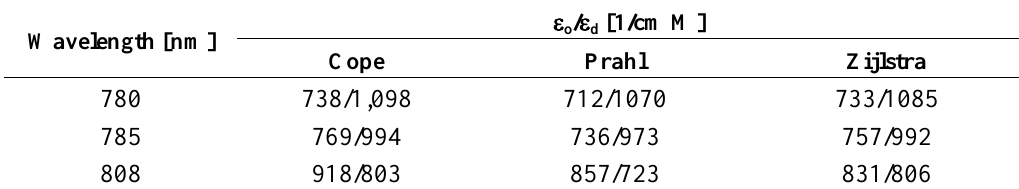
Table 1. The extinction coefficients for HbO from the tables of Zijlstra et al , Cope and